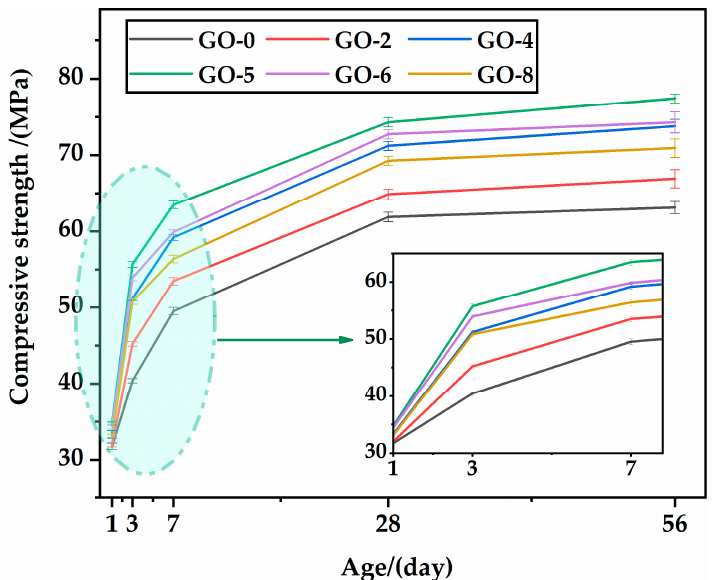
Figure 7. Compressive strength of HSLWC at di ff erent ages.